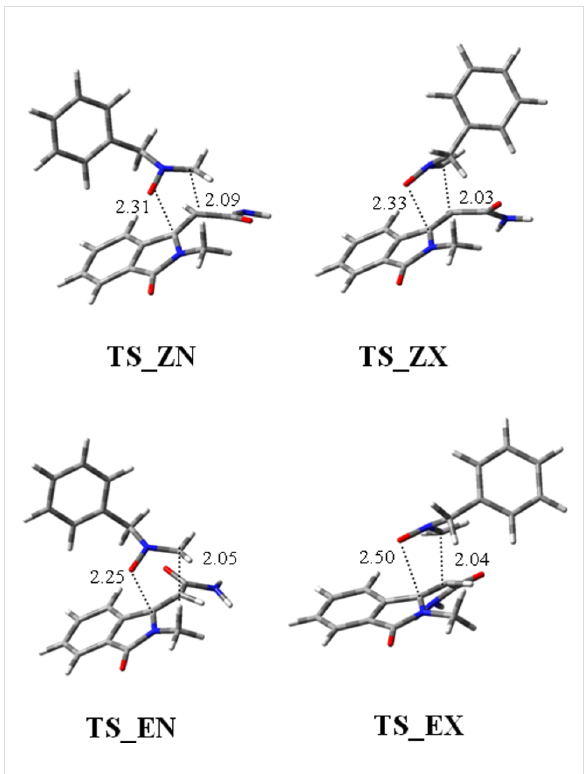
Figure 5: Three-dimensional plots of TSs of reaction of dipolarophiles ( Z )- 8 and ( E )- 8 with nitrone 4 . The labels endo N and exo E refer to the location of the nitrone N -benzyl in the formed five-membered ring on the same or opposite side of the phenyl ring of dipolarophiles. Dis- tances between atoms involved in the forming bonds (Å) are reported in the 3D plots.